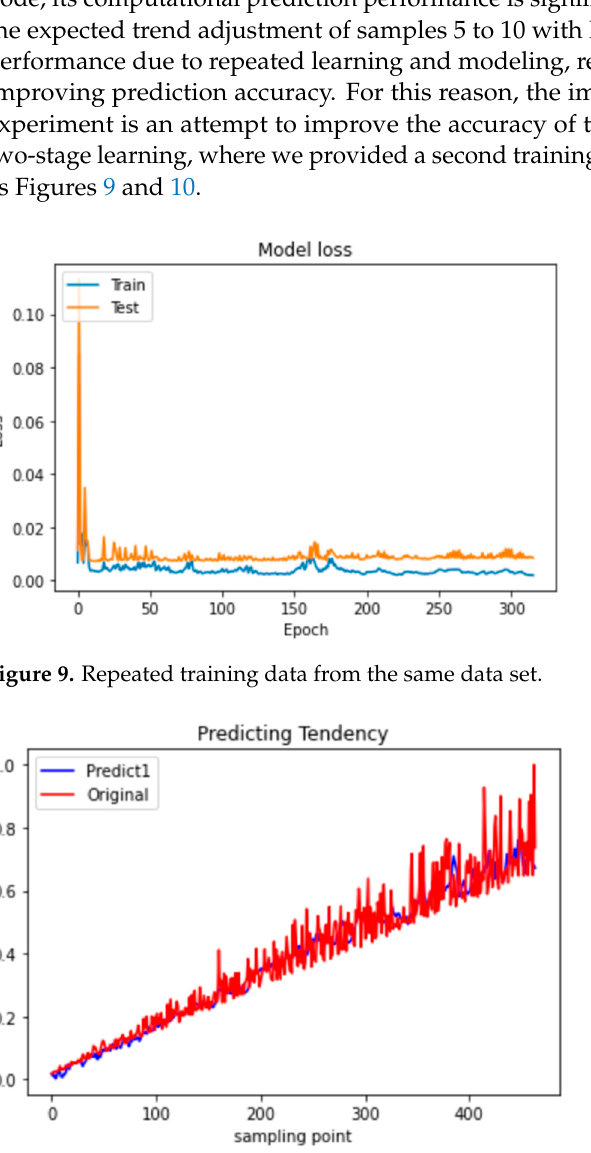
Figure 10. Results of predicting raw data after repetitive